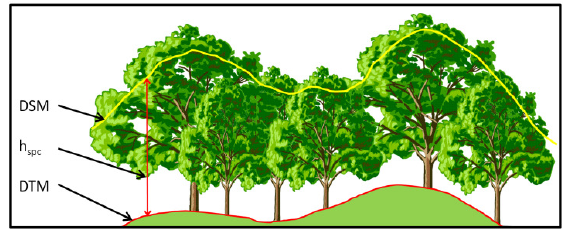
Figure 2. DSM (yellow line) minus DTM (red line) is the h spc .